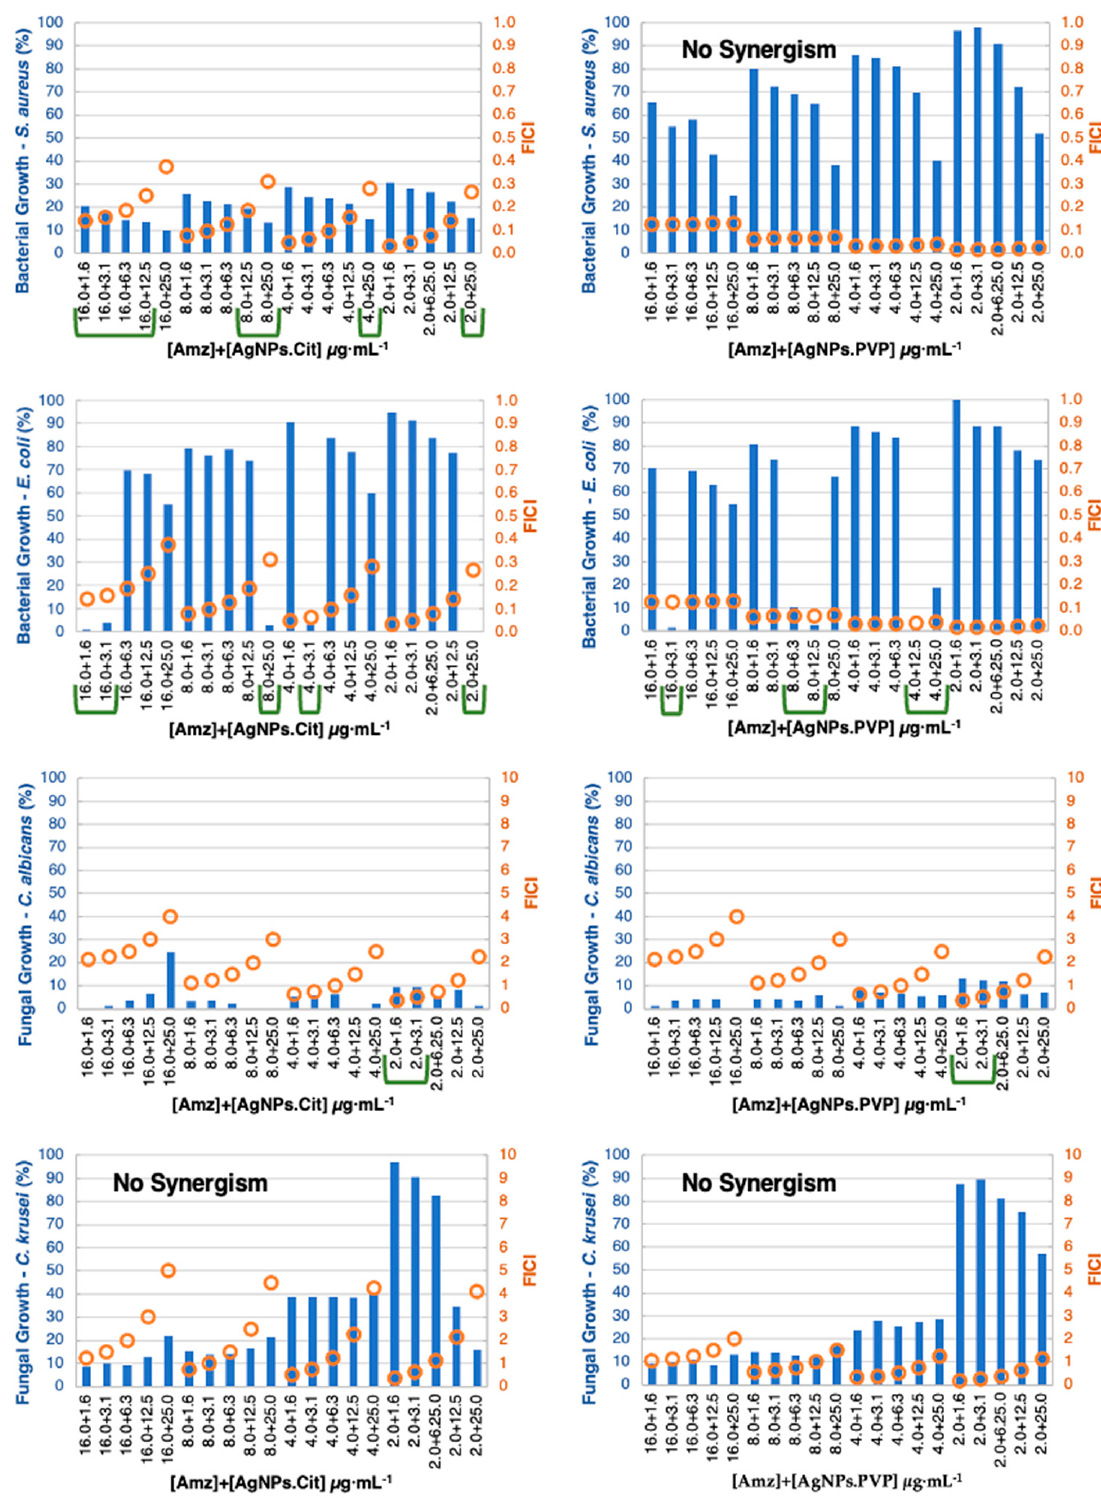
Figure 5. Checkerboard results by combining Amz (concentration ≤ 16.0 µ g · mL − 1 ) with AgNPs (con- centration ≤ 25.0 µ g · mL − 1 ) showing positive synergistic results (green lines). Bars (blue)